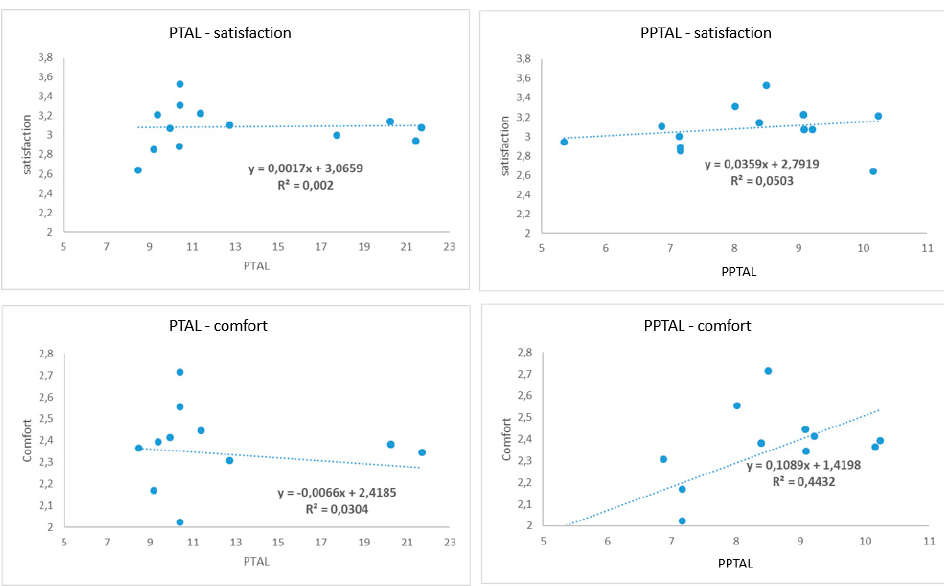
Figure 8. Results of the correlation analysis between accessibility and user satisfaction.